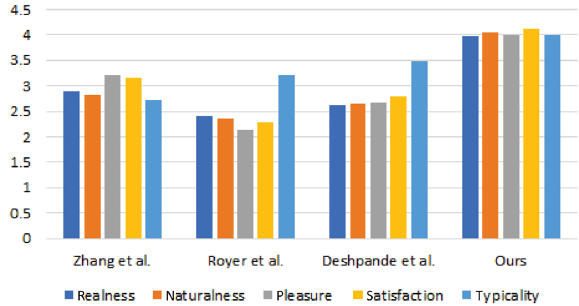
Fig. 10 Mean scores for each algorithm, for five evaluations.